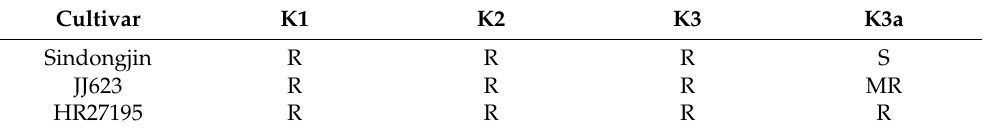
Table 1. Phenotypic evaluation in leaves of Sindongjin, JJ623 and HR27195 inoculated with four pathotypes of Xanthomonas oryzae pv. oryzae ( Xoo ) induced bacterial blight (BB). Cultivar K1 K2 K3 K3a